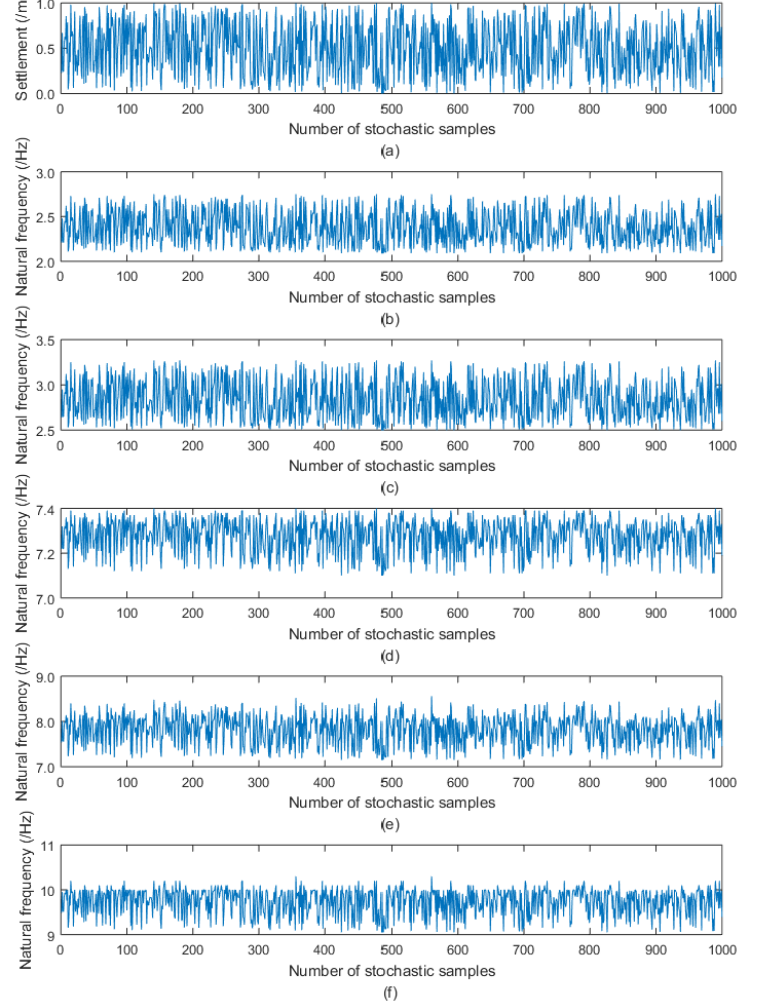
Figure 3. Records of the transmission tower settlement and the corresponding natural frequencies ( a